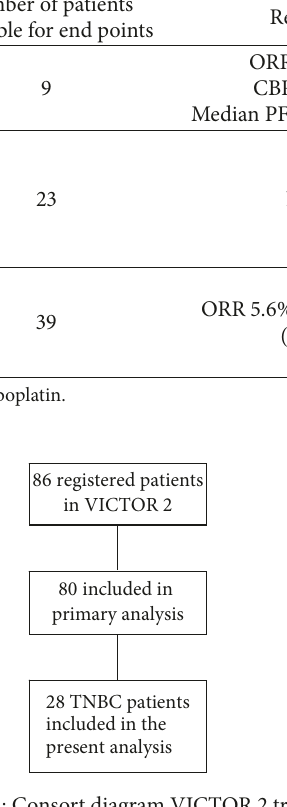
Figure 1: Consort diagram VICTOR 2